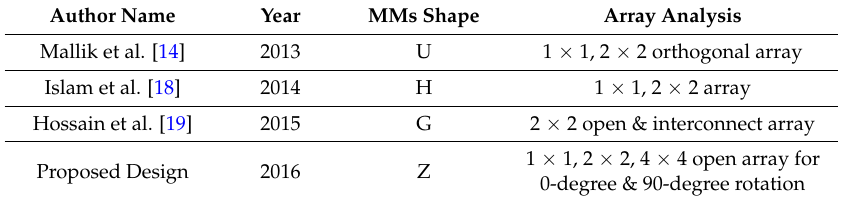
Table 3. Comparison of the proposed metamaterial array structures with the previous array